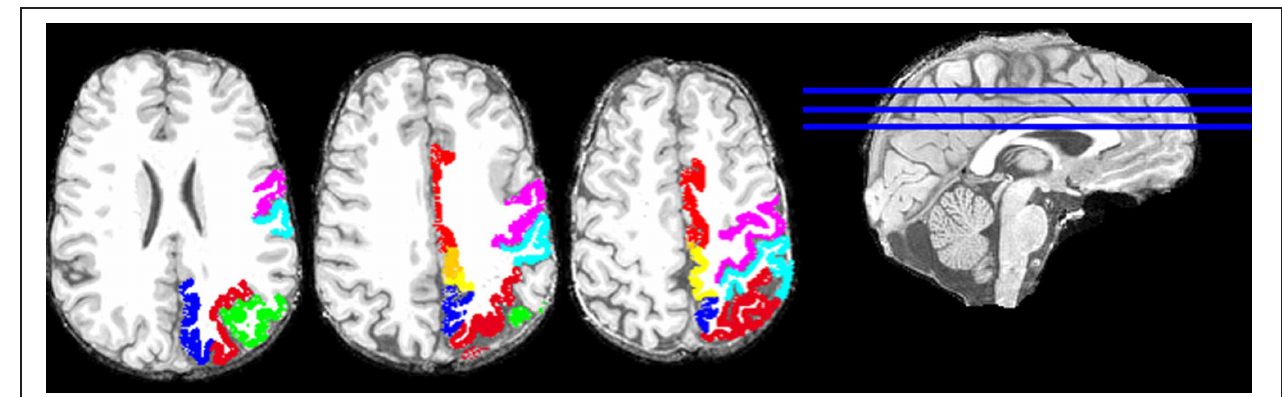
following colors: red, Cingulate Gyrus; violet, Precentral Gyrus; cyan, Postcentral Gyrus; yellow, Paracentral Lobule; green, left Inferior Parietal Lobule; blue, left Precuneus; and dark red, left Superior Parietal